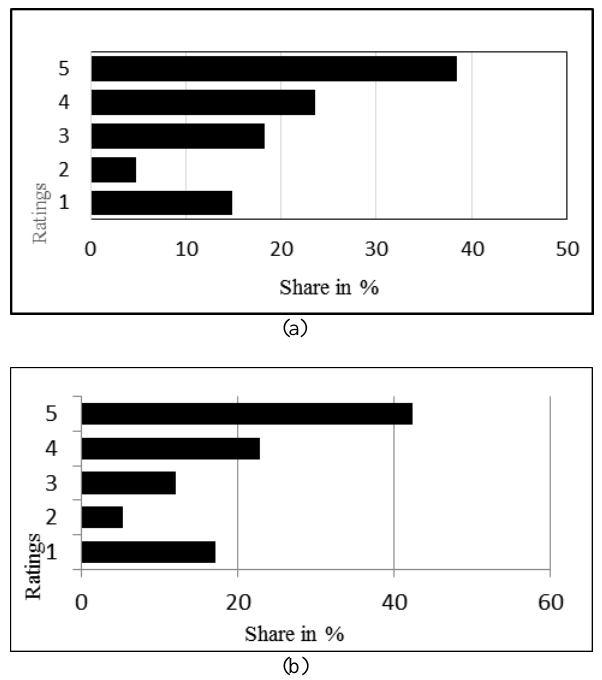
Figure 1(a) Percentage Share of Star Ratings Provided by International Patients and (b) Domestic